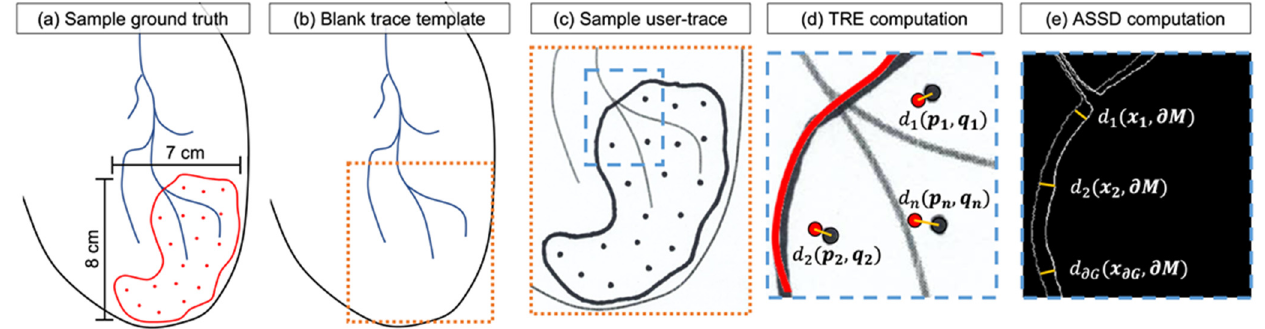
Figure 4. ( a ) A sample ground truth target showing the contour and target points in red. ( b ) A sample trace template and ( c ) scanned user trace result. ( d ) A sample target registration error (TRE) calculation, with circles fit to user-trace and ground truth points; ( e ) an average symmetric surface distance (ASSD) computation.